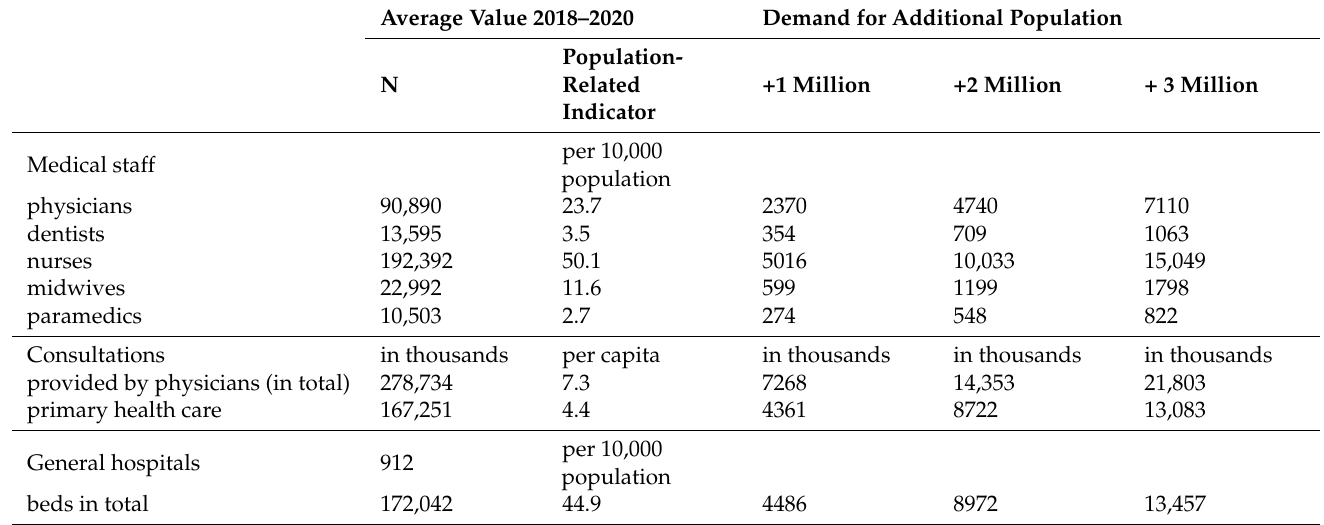
Table 1. Basic data on health care resources and activity indicators in Poland and the estimated need to increase resources and health services as a consequence of the influx from Ukraine into